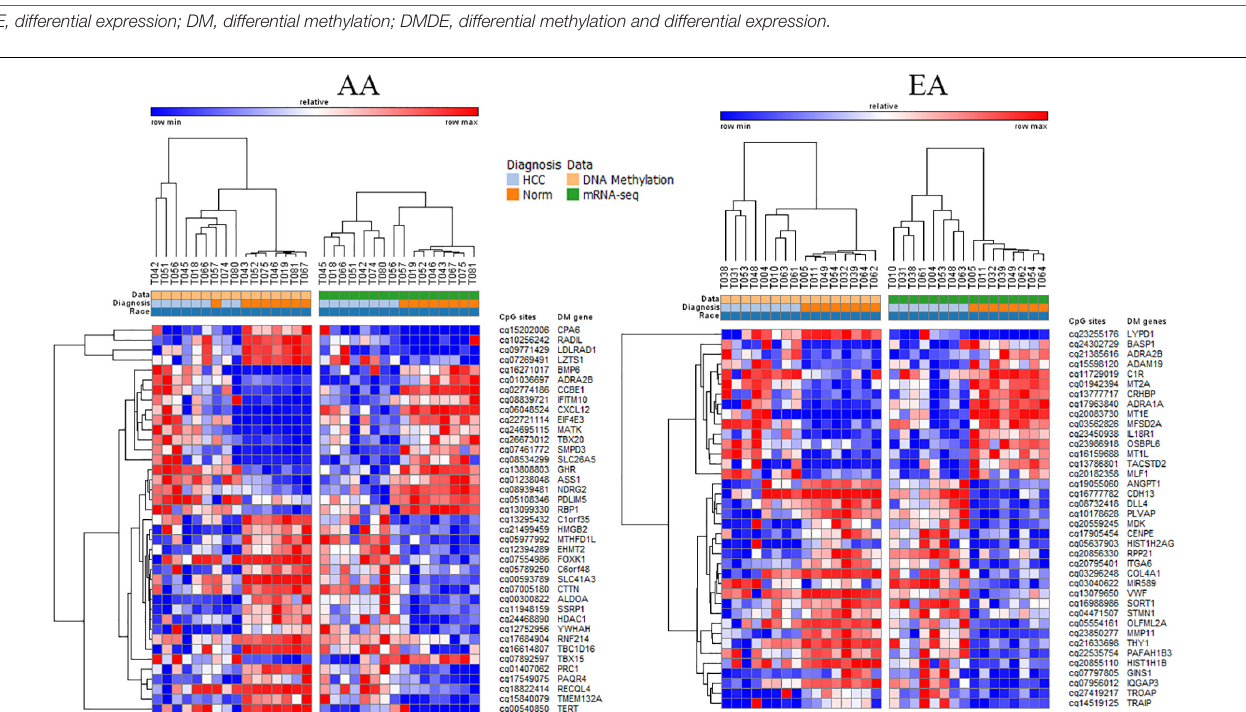
each omics dataset between AA, EA, and ALL are shown in Supplementary Figure 1